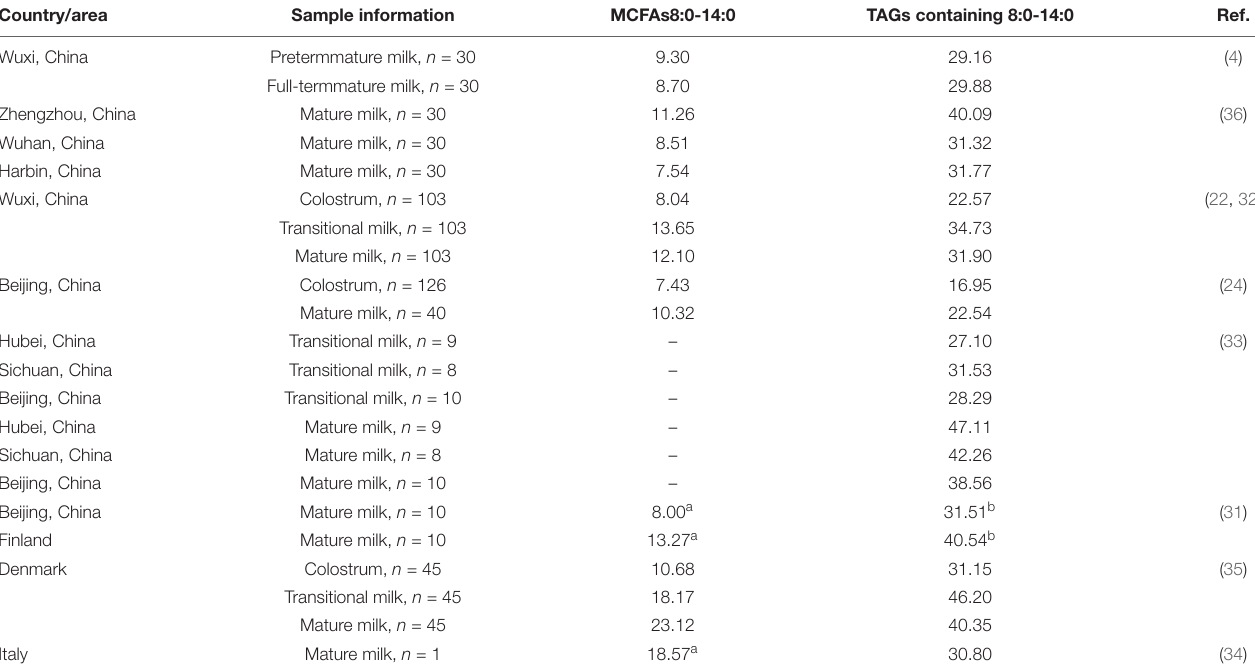
TABLE 1 | Content of MCFAs and TAGs containing MCFAs in human milk*.